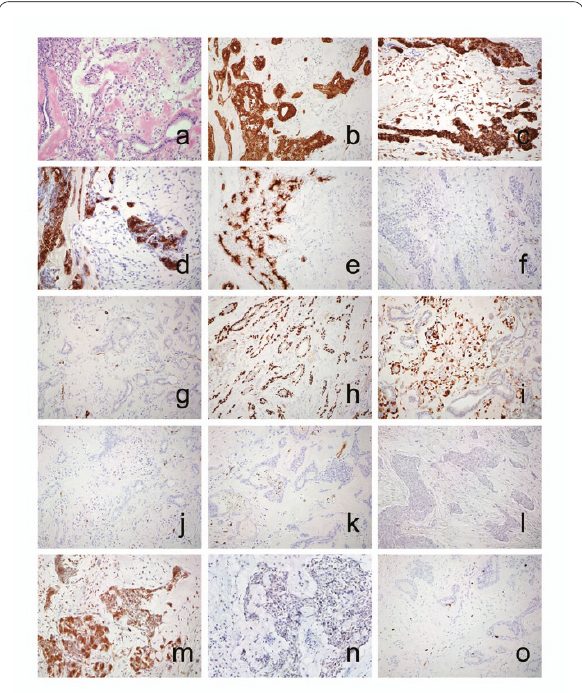
Figure 3 Comprehensive immunohistochemical staining: a, repre- sentative section by H-E stain (×200); b, Cytokeratin (CK) AE1/AE3 (×200); c, CK CAM5.2 (×200); d, CK 34βE12 (×200); e, EMA (×200); f, desmin (×200); g, α-smooth muscle actin (×200); h, p63 (×200); i, S-100 protein (×200); j, CD31 (×200); k, CD34 (×200); l, p53 (×200); m, bcl-2 (×200); n, p16 (×200); o, Ki-67 (×200).